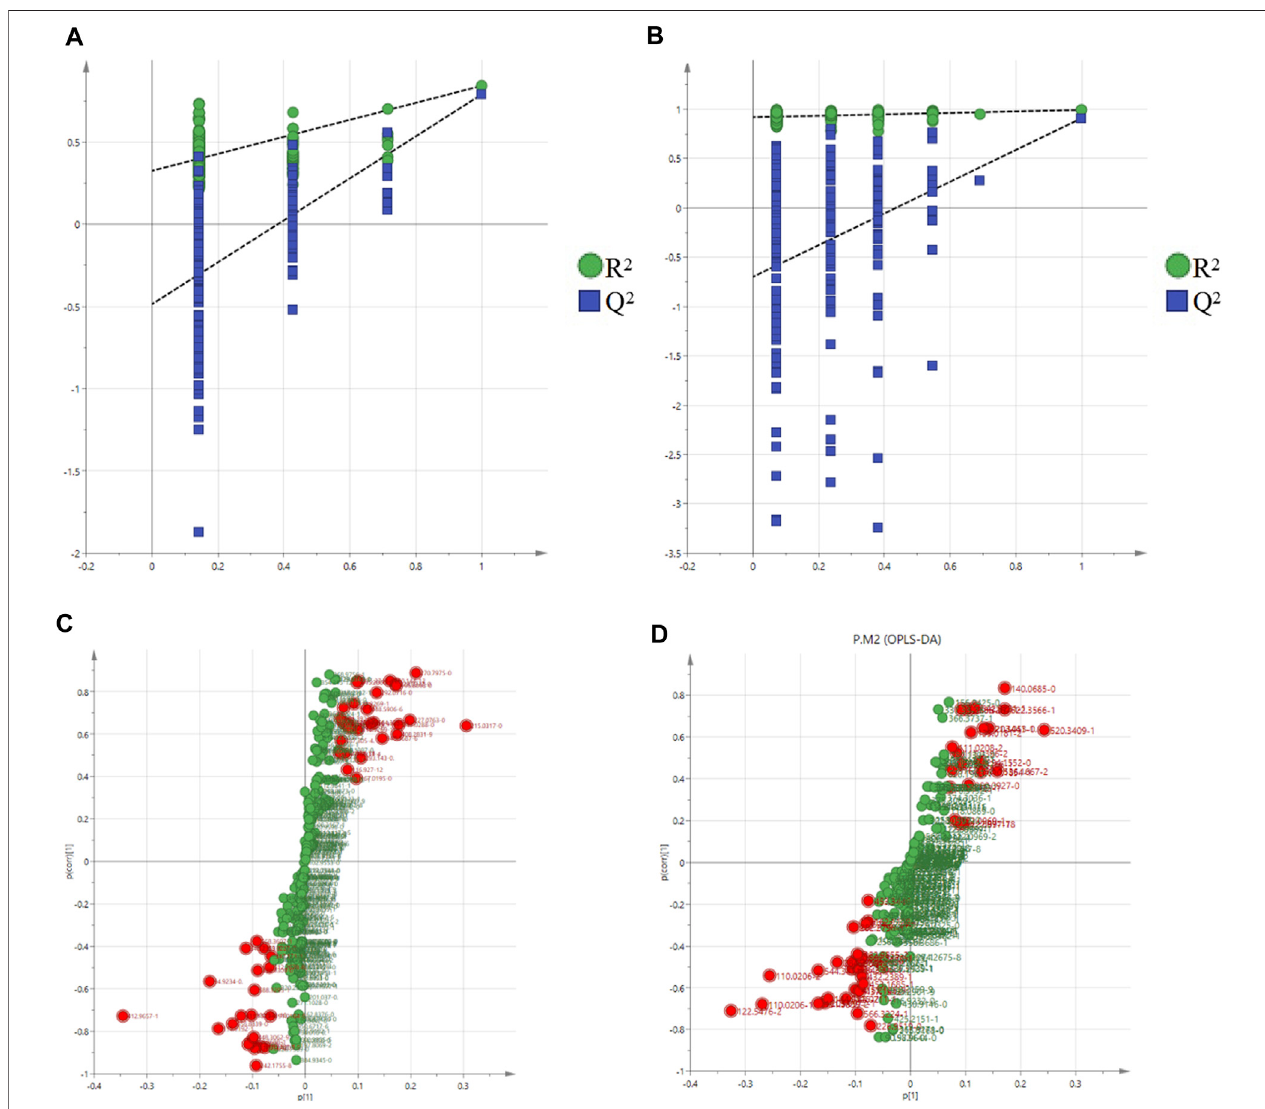
FIGURE 7 | Permutation test of the OPLS-DA model in the positive mode (A) and negative mode (B) ; S-plot in the positive mode (C) and negative mode (D) .